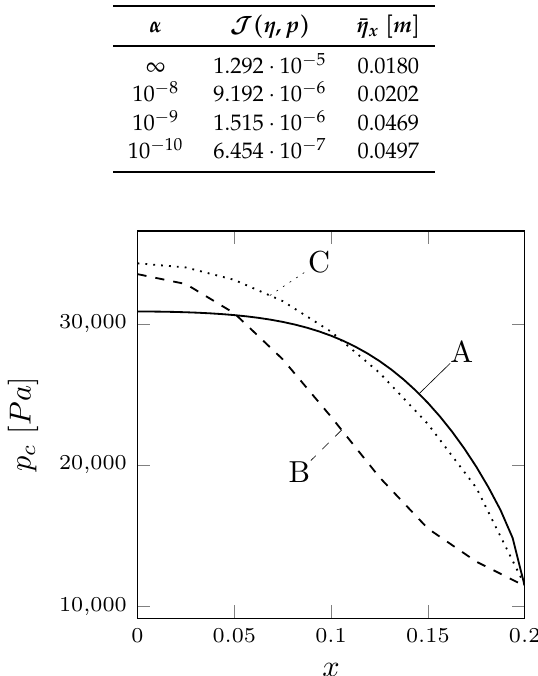
Table 1. Objective functional. The reference case with no control is labeled with α = ∞ .